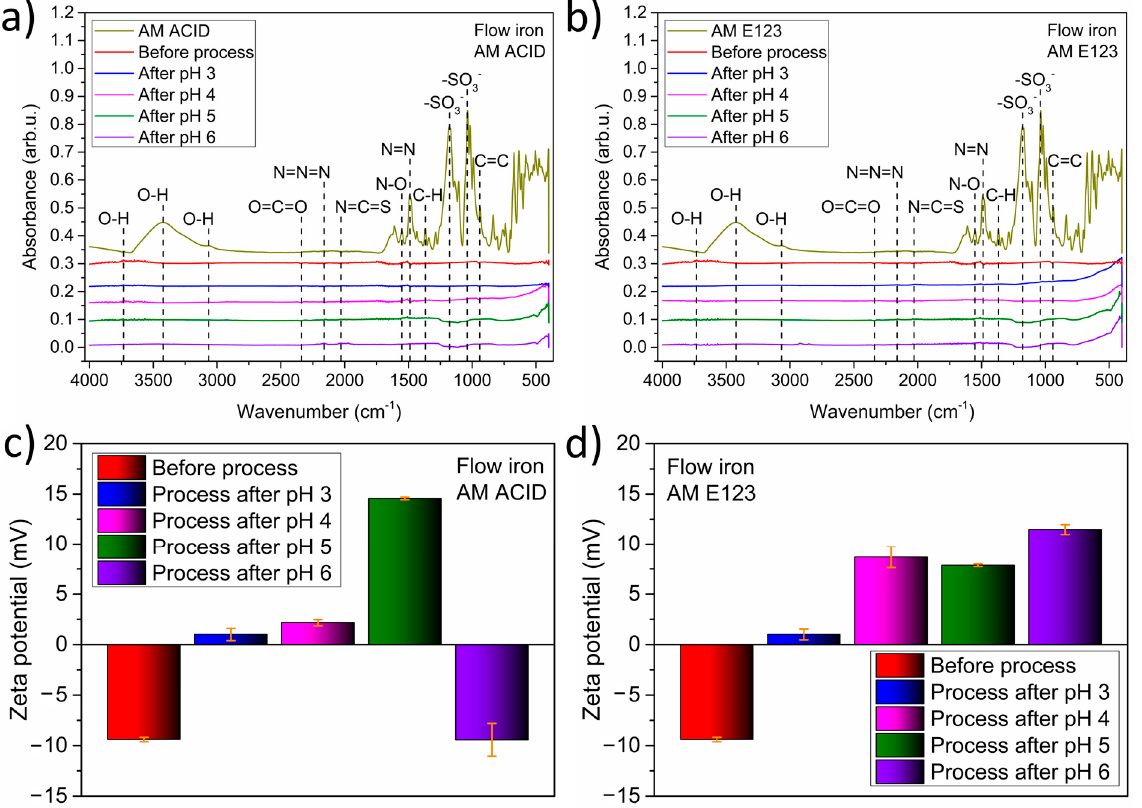
Figure 5. Catalyst surface analysis with ( a ) AM ACID and ( b ) AM E123, and stability with ( c ) AM ACID and ( d ) AM E123 after 60 min of the UV/ZVI/H 2 O 2 process.